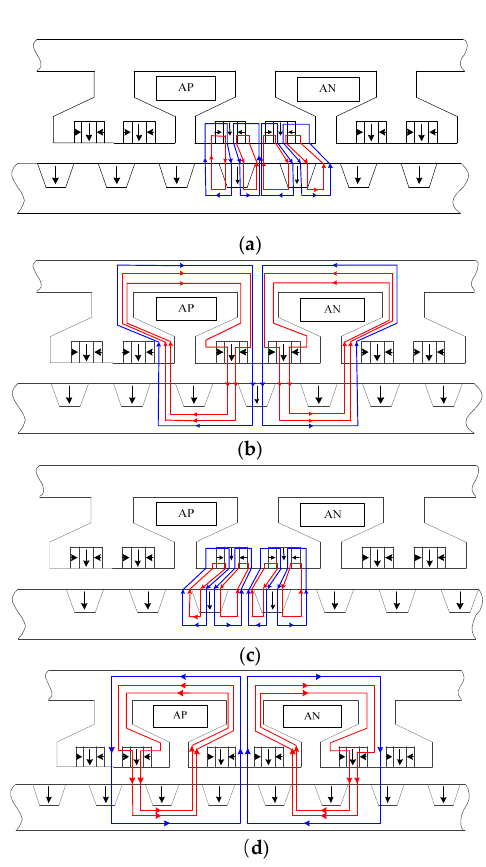
Figure 2. Operation principle of the proposed machine. ( a ) 0°. ( b ) 90° . ( c ) 180° . ( d ) 270°